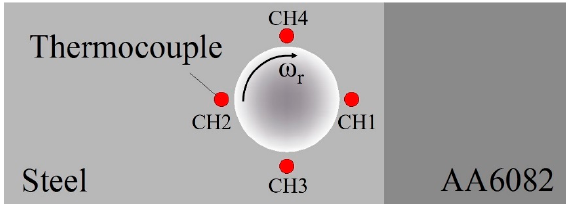
Figure 2. Schematic diagram of thermocouple distribution around the dissimilar Al/steel keyhole-free FSSW joint.